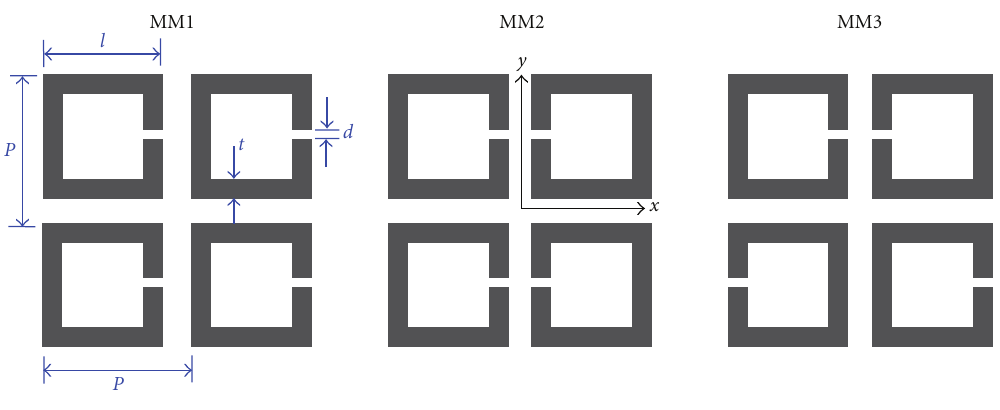
Figure 5: Unit cell of the three types of di ff erently oriented split-ring resonators. The dimensions of all SRRs are t = 6 μ m, l = 36 μ m, and d = 2 μ m. In the design, the period P is varied.